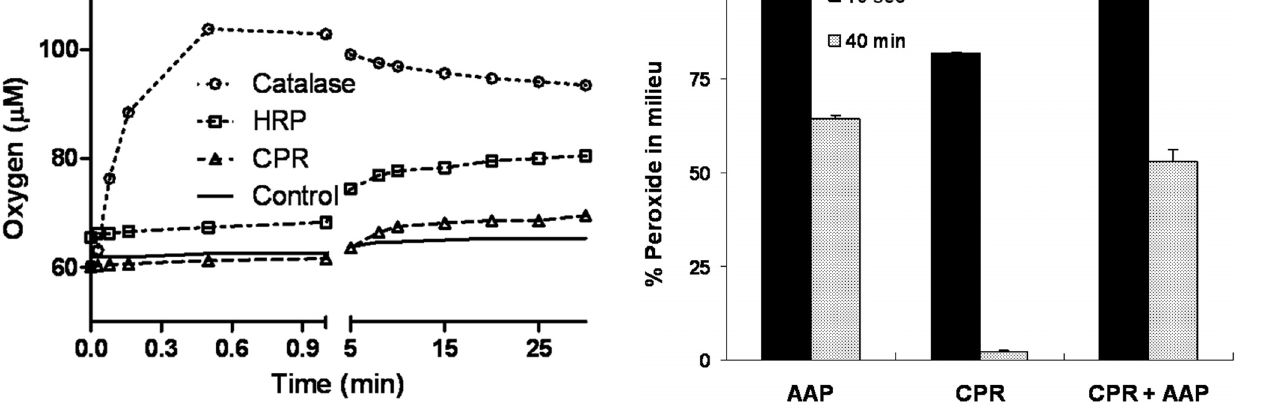
Figure 3. Tracing of oxygen evolution in peroxide depletion reactions.